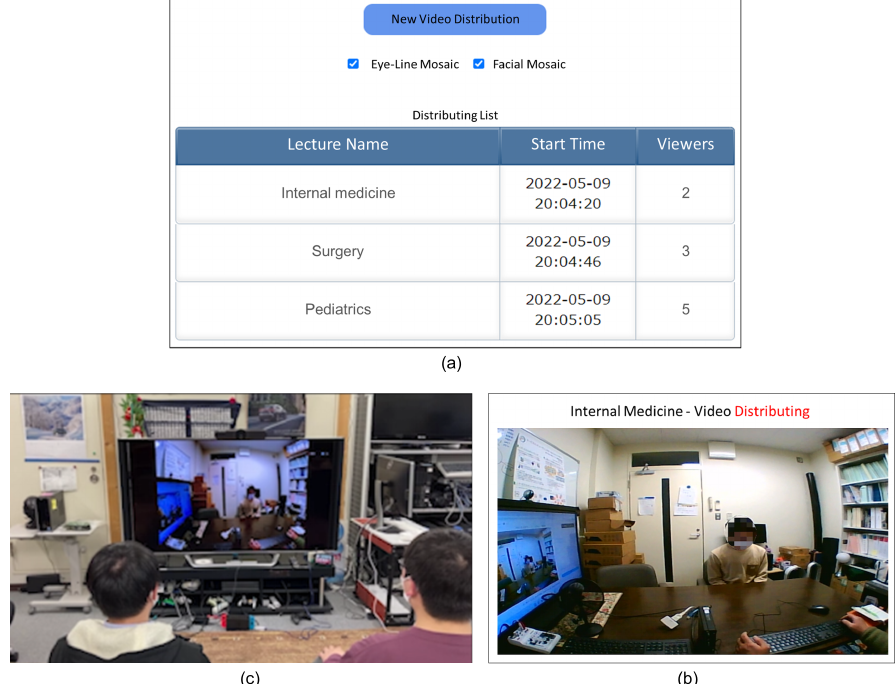
Figure 8. Web UI and scene: ( a ) Home page. ( b ) Video distribution page. ( c ) Video viewing